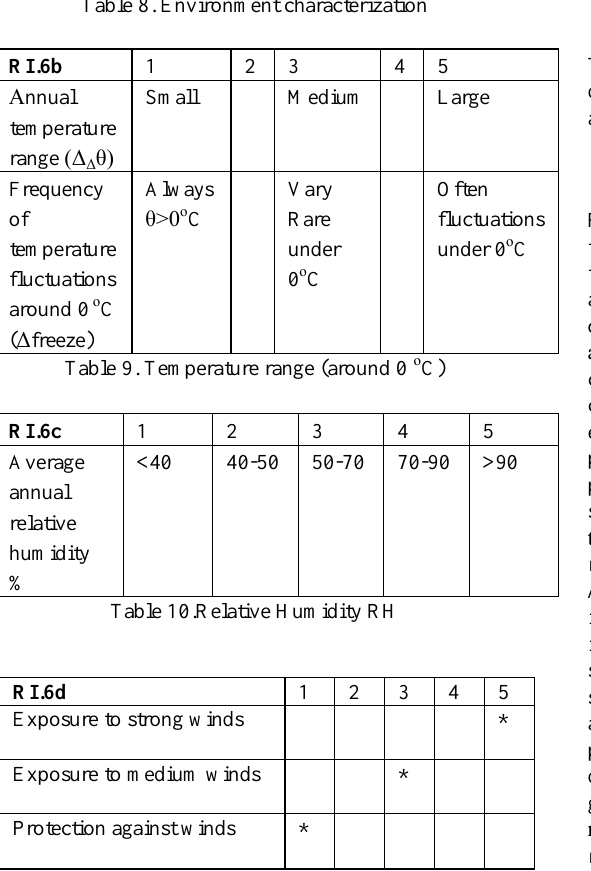
Table 11.Surface exposure to wind